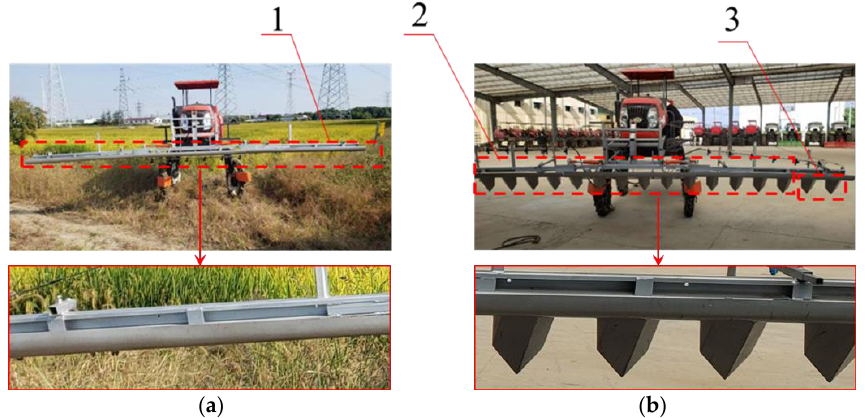
Figure 2. Spraying platform installation of the canopy-opening device and the canopy-opening divider combination device. ( a ) Boom sprayer with the canopy-opening device; ( b ) boom sprayer with the canopy-opening divider combination device. 1. The canopy-opening device; 2. the canopy-opening divider combination device; 3. the divider device.